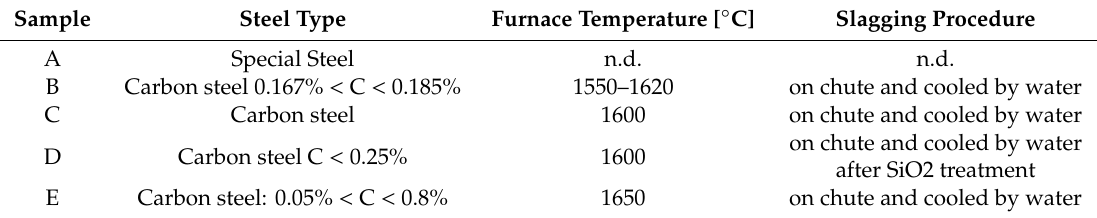
Table 1. Description of samples, details of some steel making process parameters (2nd and 3rd column) and slagging procedure (4th column).